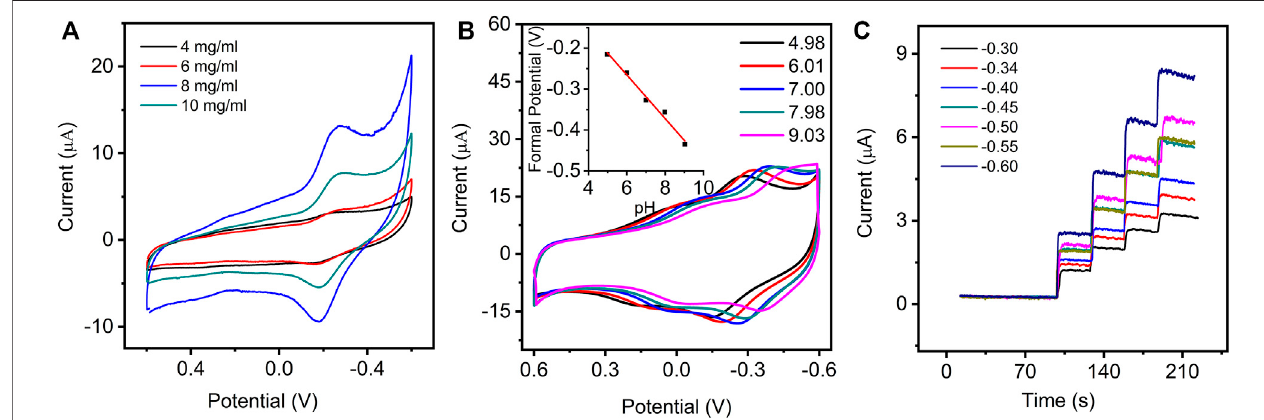
FIGURE 3 | (A) CVs of GO – NMB/GCE in 0.1 M PBS (pH 7.0) with various concentrations of GO – NMB modi fi ed solution from 4 to 10 mg ml − 1 . (B) CVs of GO – NMB/GCE in PBS with various pH (inset: the plot of the relationship between formal potential and different pH). (C) The amperometric current − time curves of GO – NMB/GCE at different applied potential with successive injections of the same volume of hydrogen peroxide (H 2 O 2 ).